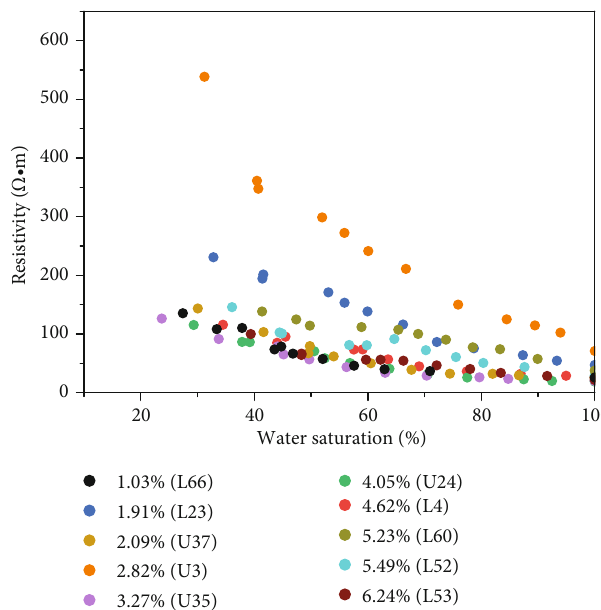
Figure 9: Relationship between rock resistivity and water saturation in deep shale